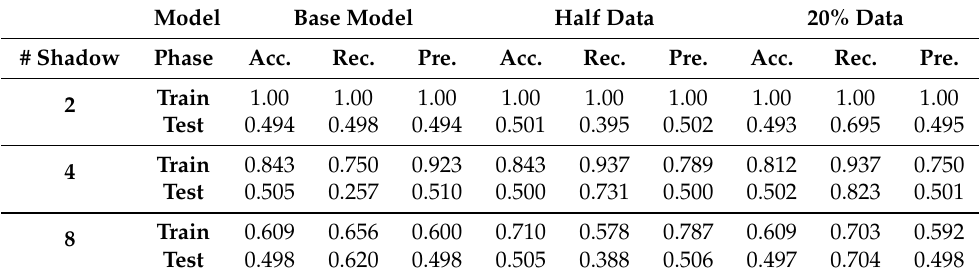
Table 6. Membership inference attacks results on MNIST